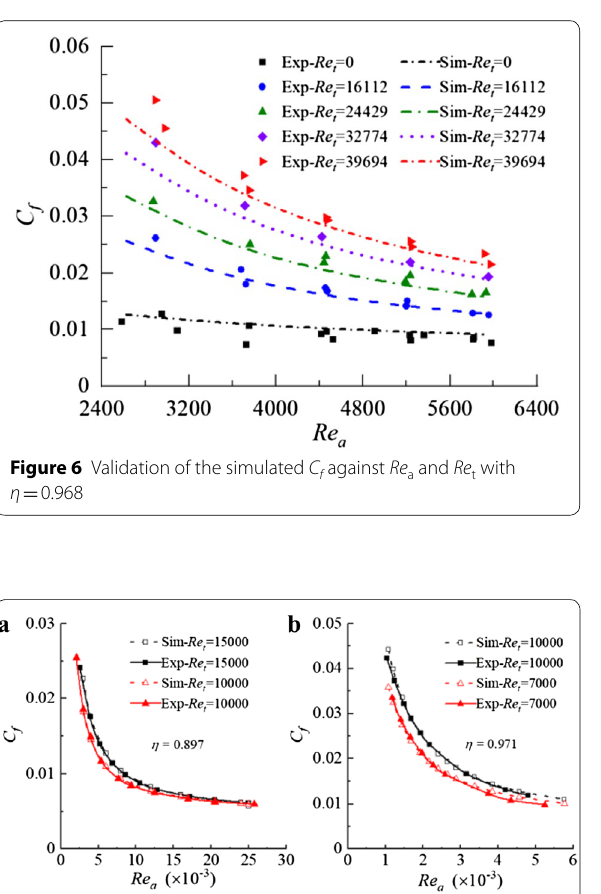
Figure 7 Simulated C f compared with experiments: ( a ) η η =